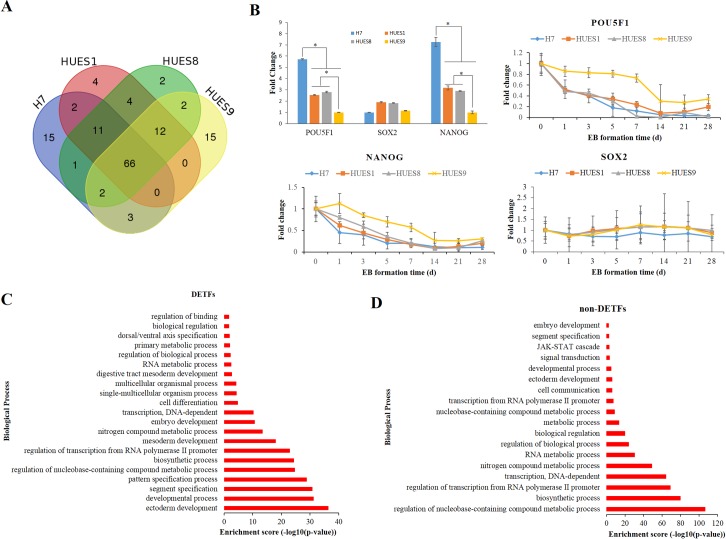
Expression variability of transcription factors among hESC lines H7, HUES1, HUES8 and HUES9.(A) Venn diagram showing top 100 highly expression transcription factors (TFs) TFs in the four cell lines. (B) Expression variation of pluripotent factors POU5F1, NANOG and SOX2 in the four cell lines. Top left histogram exhibits fold change (FC) compared to lowest expressed cell lines (data from RNA-seq). * represents FC >2 and FDR < 0.01. The other three charts show POU5F1, NANOG and SOX2 expression change during EB formation (data from RT-PCR) and fold change of each gene was normalized by expression level of hESC for each line. (C) GO-slim biological process enrichment analysis of DETFs at least between any two cell lines. (D) GO-slim biological process enrichment analysis of non-DETFs among the four cell lines.